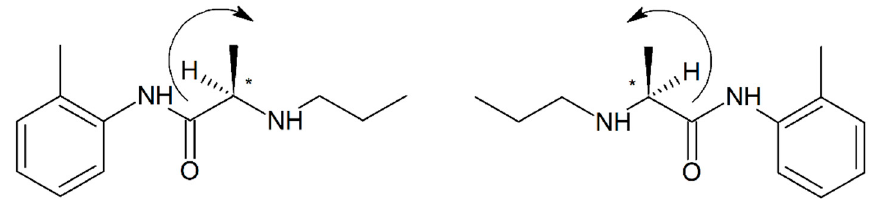
Figure 1. Structures and stereochemistry of ( R )-prilocaine (left) and ( S )-prilocaine